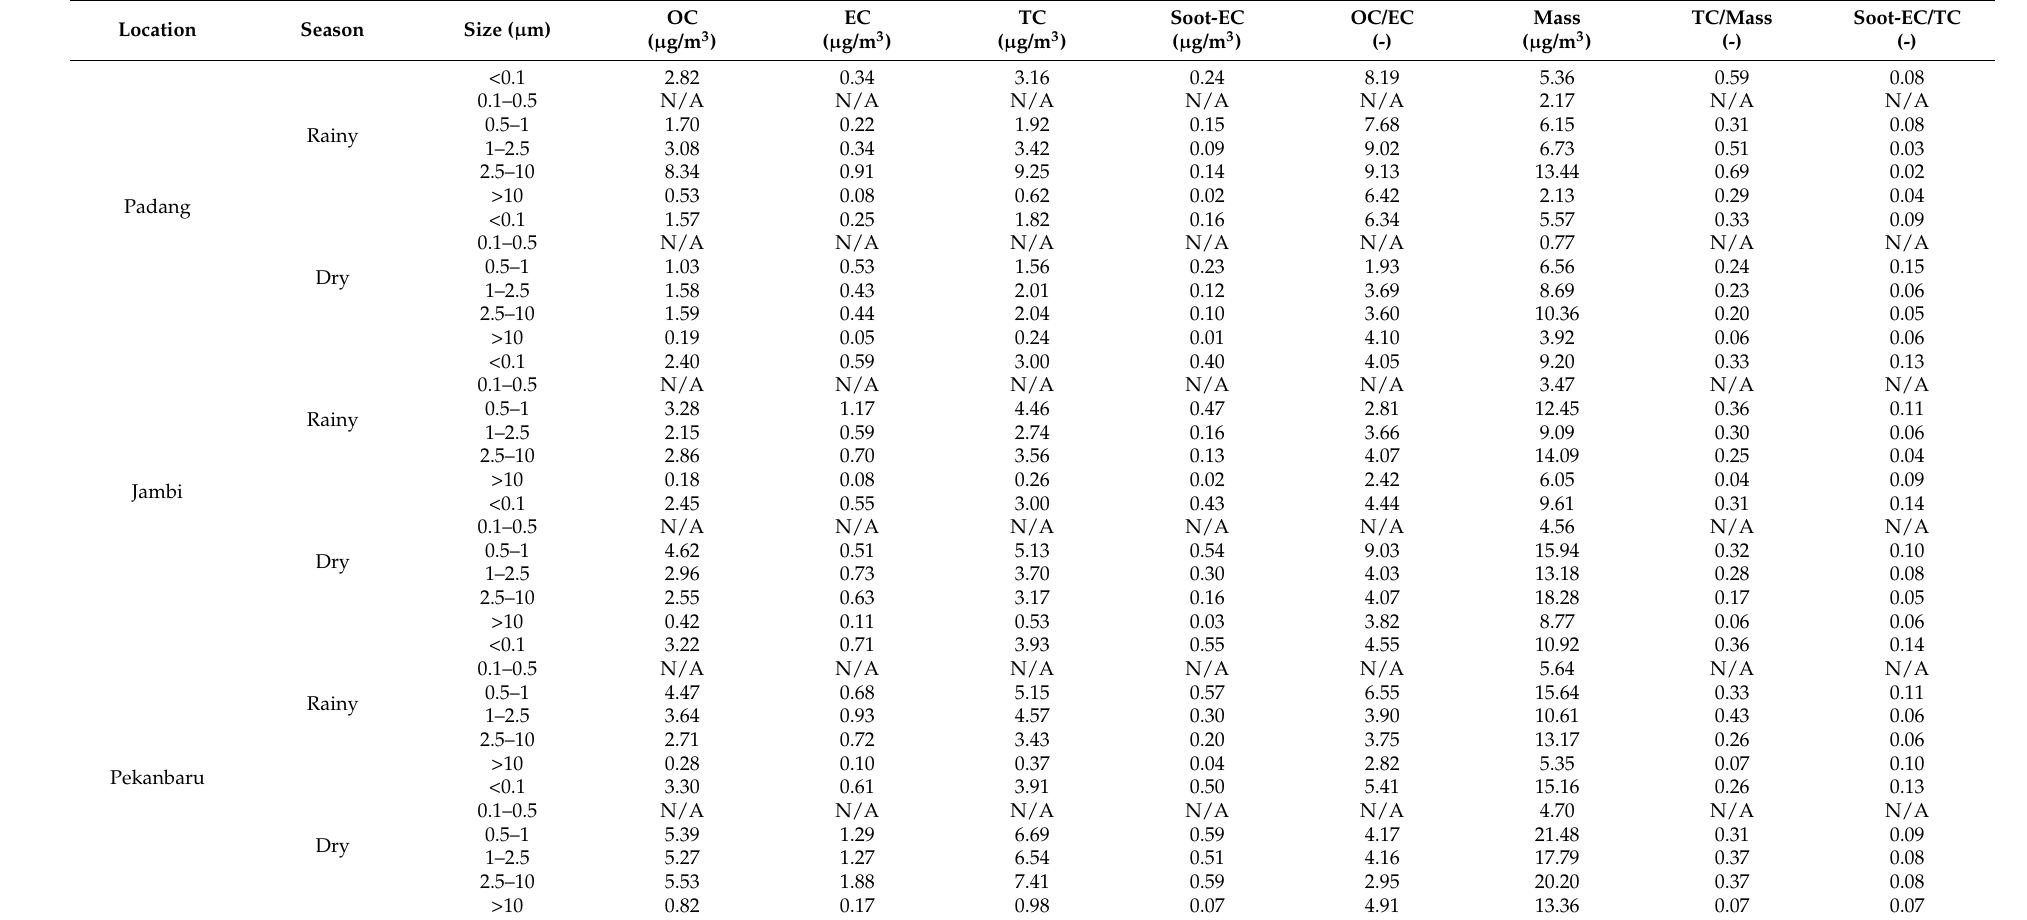
Table 2. Seasonal average concentrations of carbonaceous components in Sumatra